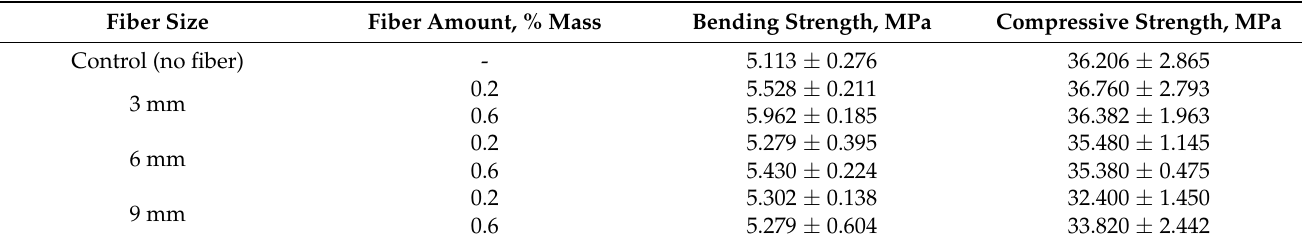
Table 4. Test results of the samples reinforced with carbon